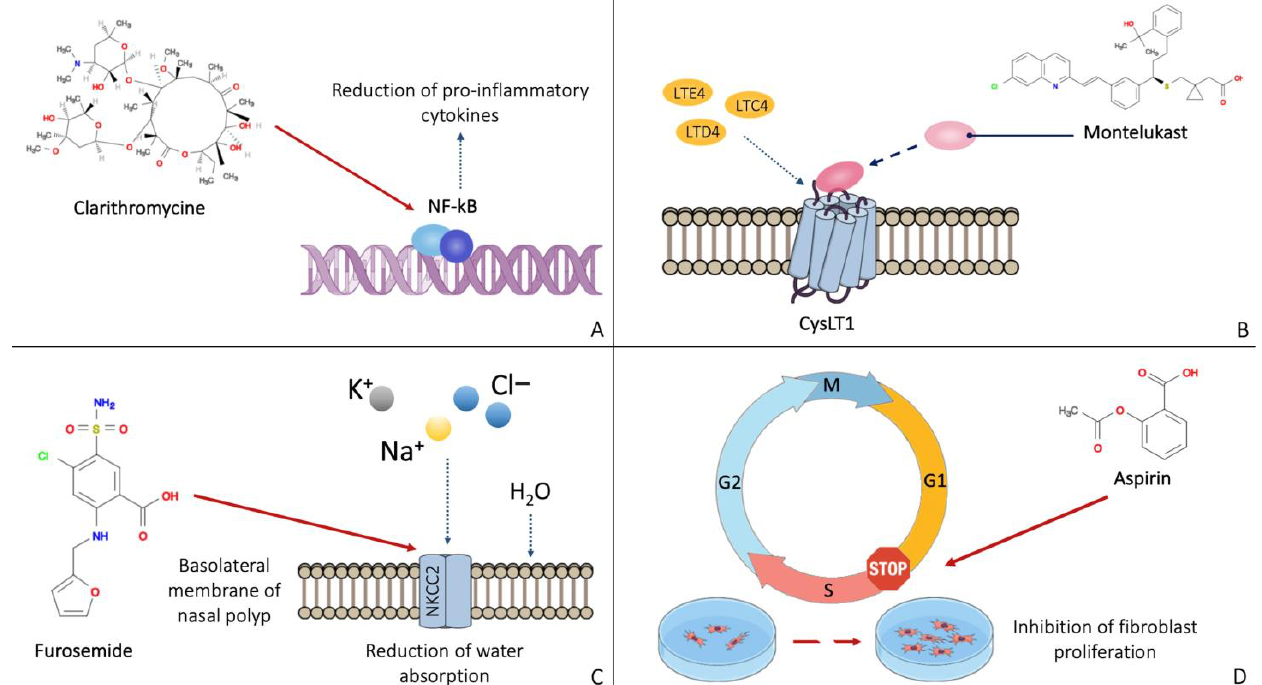
Figure 2. Mechanisms of action of the main molecules active on the nasal polyp: clarithromycin has an anti-inflammatory effect by inhibiting NF-kB ( A ). Montelukast binds the leukotriene receptor CysLT1, preventing its activation ( B ). Furosemide inhibits the NKCC2 receptor on the basolateral membrane of nasal polyp cells ( C ). Aspirin appears to block cells in the G1 phase, preventing the proliferation of fibroblasts ( D ).